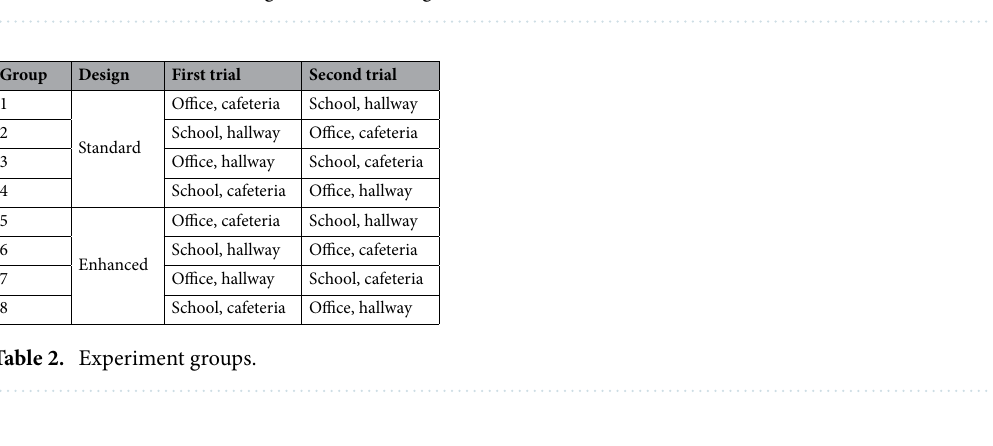
Figure 2. Virtual occupants and the virtual shooter. ( A ): occupants from the view of the starting location in the cafeteria. ( B ): occupants from the view of the starting location in the hallway. ( C ): shooter entering the building from the main entrance (see Fig. 1 for the starting locations and main entrance).